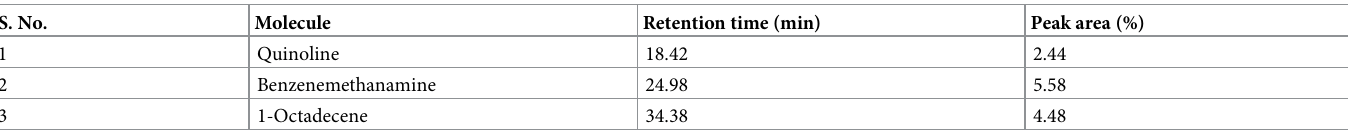
Table 3. Analysis of B . simplex 350–3 volatiles through GC-MS/MS. S.